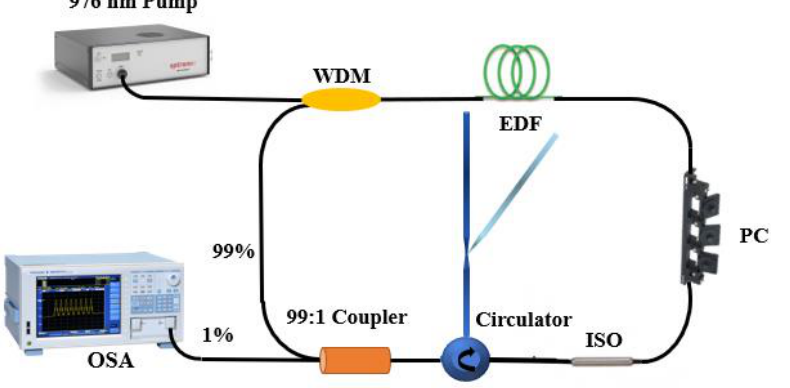
Figure 4. Experiment setup of the proposed fiber laser inclinometer.